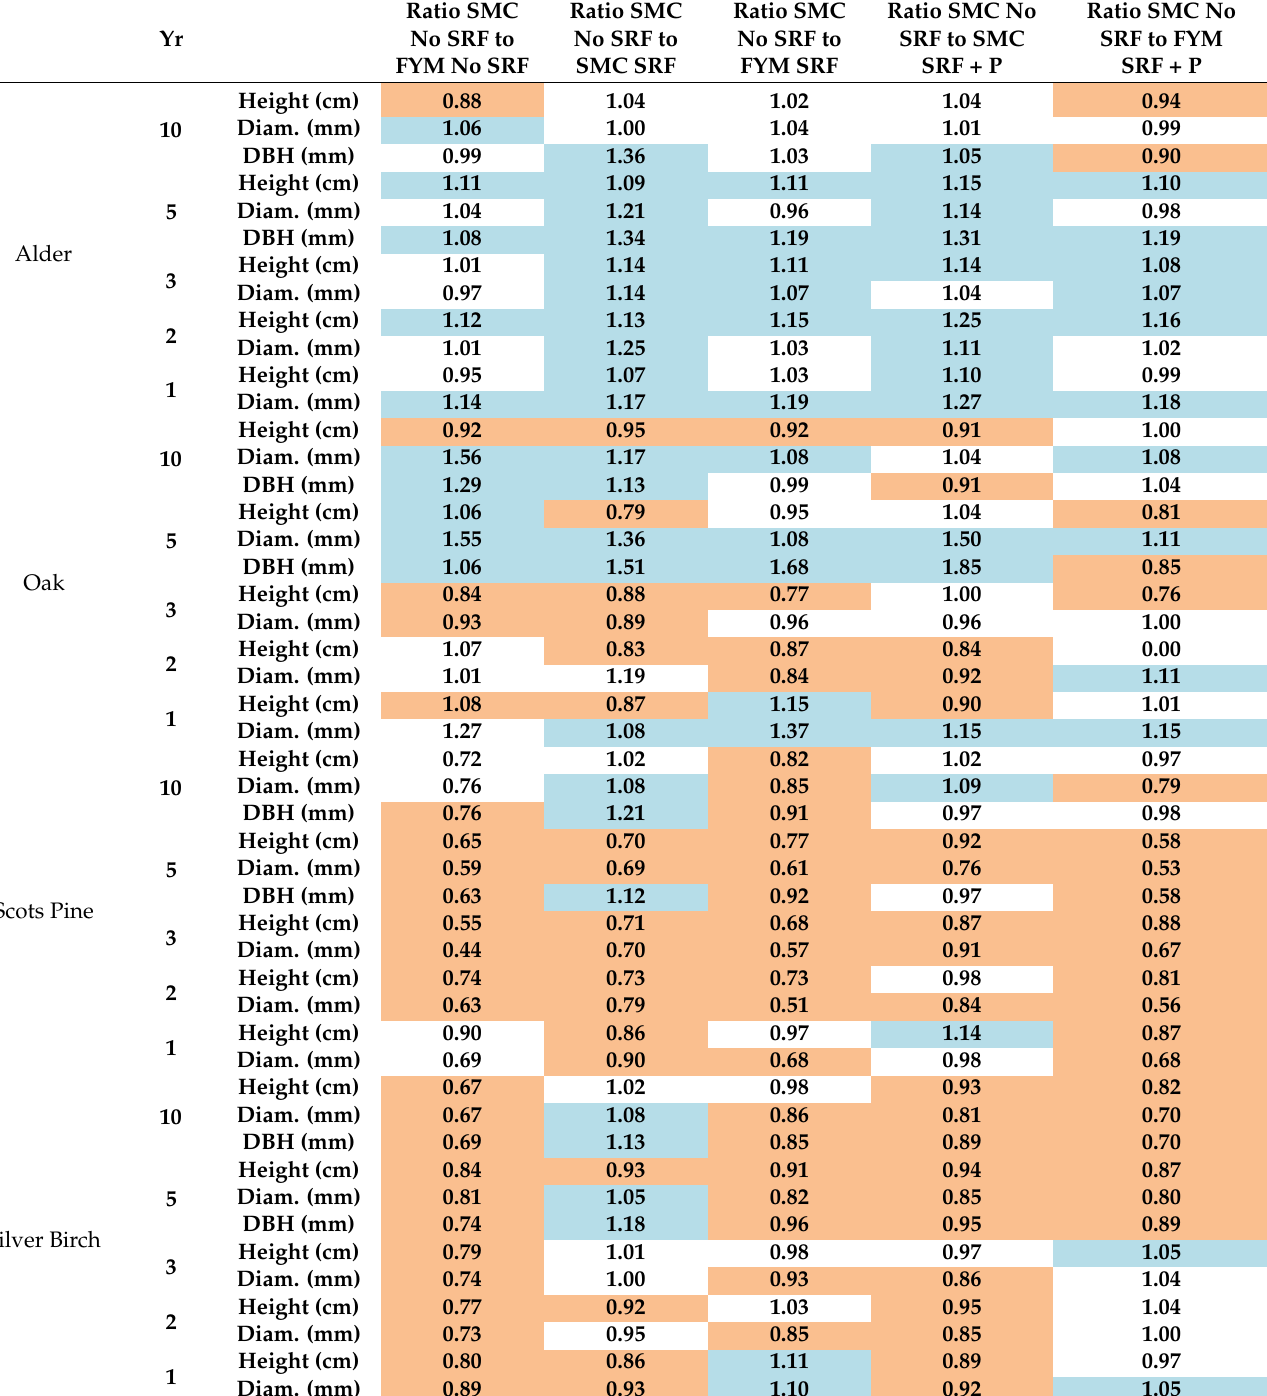
Table 14. FYM/SMC ratio with SMC no SRF. This shows differences in growth between planting with SMC alone and planting with FYM and/or fertilizer supplements. (Amber indicates that the differences are >5% negative and blue >5%